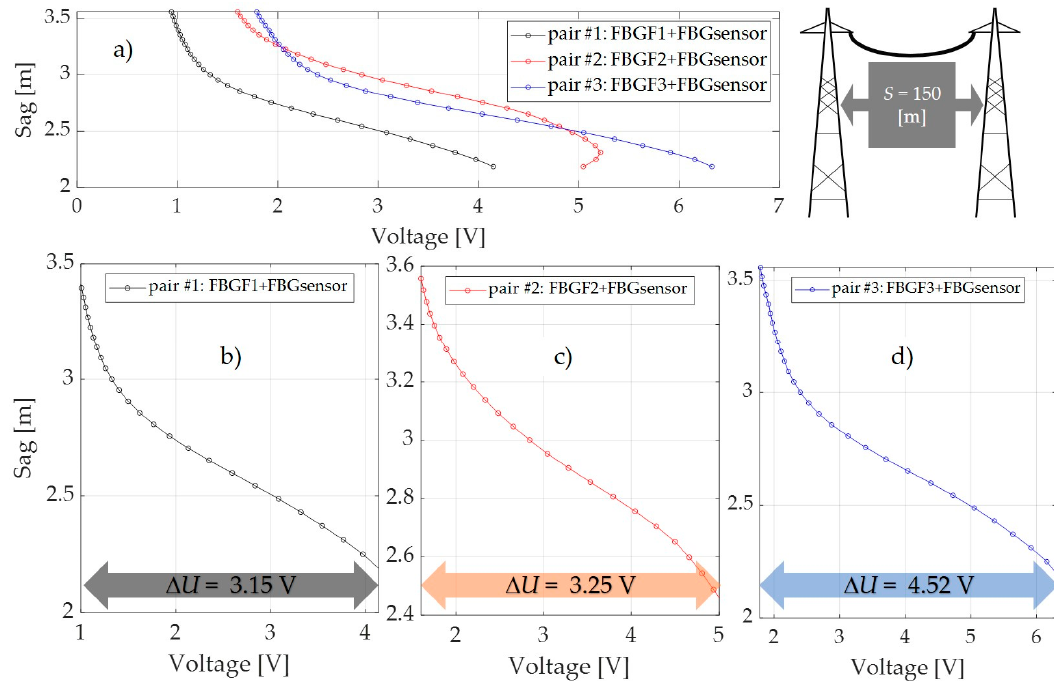
Figure 22. The results of the power line wire sag as a function of the photodetector measured voltages for power line #2: ( a ) the sag characteristics for three pairs of FBG structures; ( b ) sag dependence on the photodetector measured voltage for pair #1; ( c ) sag dependence on the photodetector measured voltage for pair #2; ( d ) sag dependence on the photodetector measured voltage for pair #3.